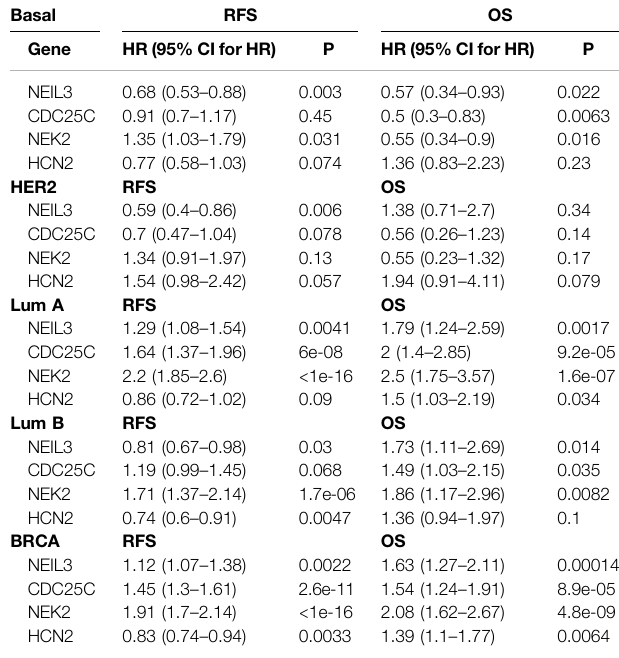
TABLE 4 | Prognostic value of the key common DEGs in total and different subtype breast cancers.